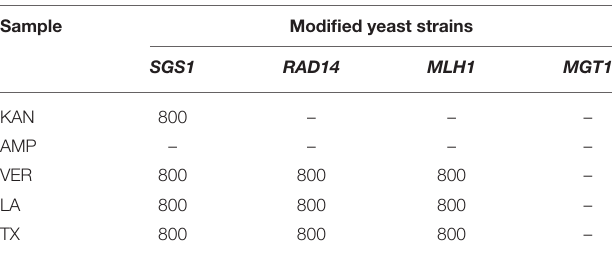
TABLE 3 | Minimum inhibitory concentration of antibiotics and SCB extracts against modified yeast strains ( µ g/mL).